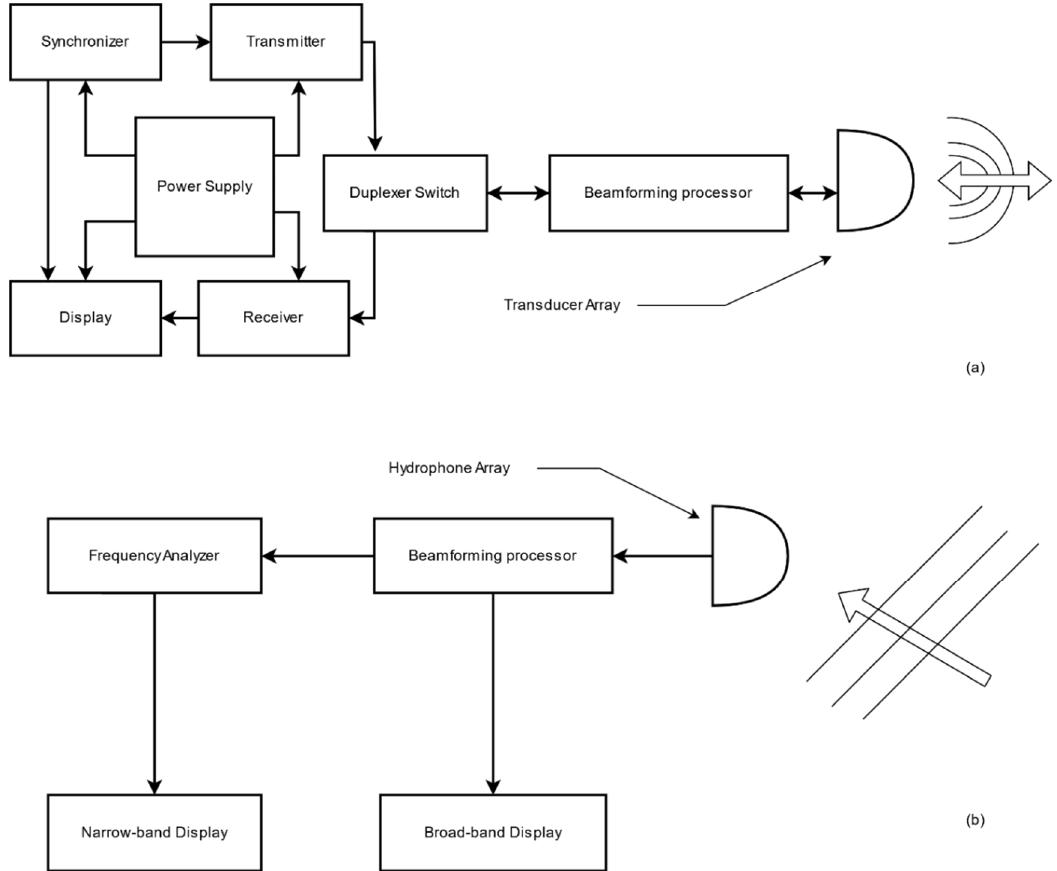
Figure 1. ( a ) Active sonar system, ( b ) Passive sonar system [10] .